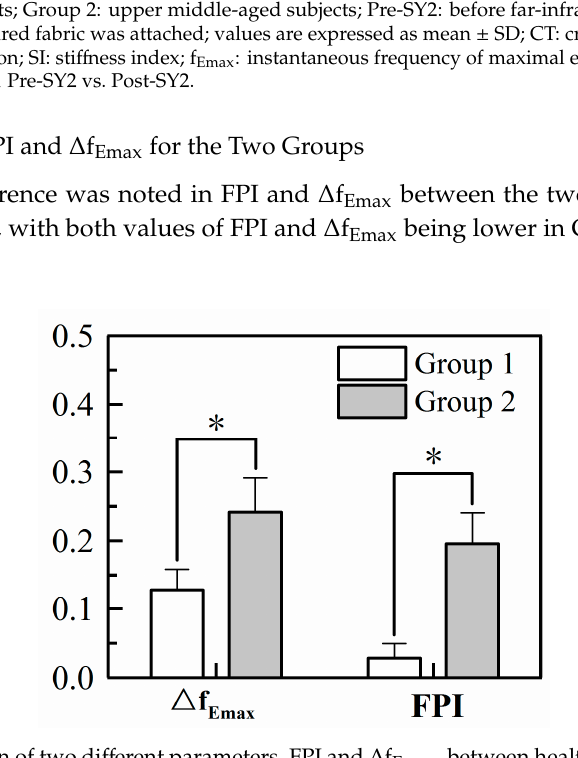
Figure 4. Comparison of two different parameters, FPI and Δ f Emax , between healthy young and healthy upper middle-aged subjects. Group 1: healthy young volunteers; Group 2: healthy upper middle-aged volunteers. FPI: finger perfusion index; Δ f Emax : instantaneous frequency difference; * p <